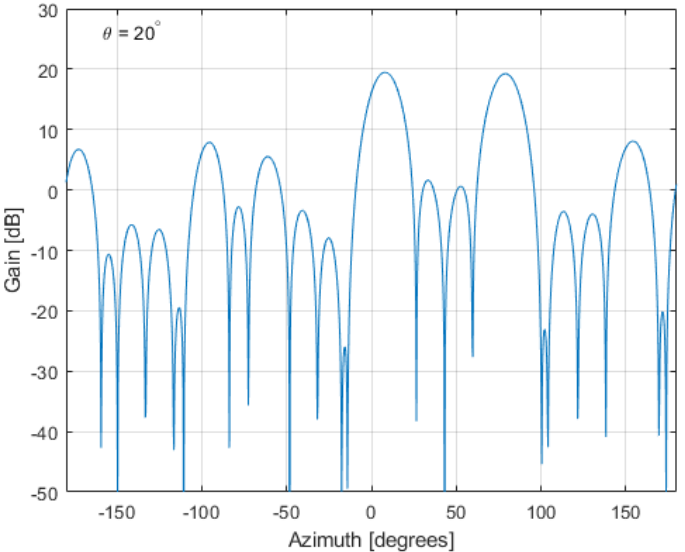
Figure 10. Horizontal cut at 20 ◦ elevation of the beam pattern of the LOFAR tile with the beam steered at φ til = 8 ◦ and θ til = 20 ◦